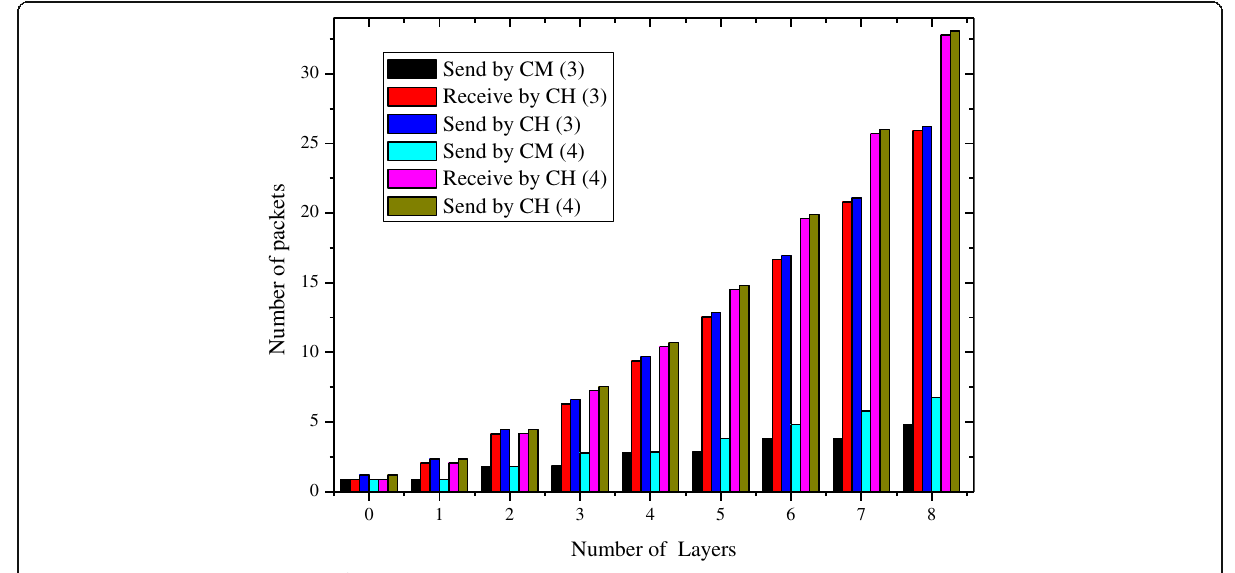
Fig. 6 The number of packets when d CH takes different values